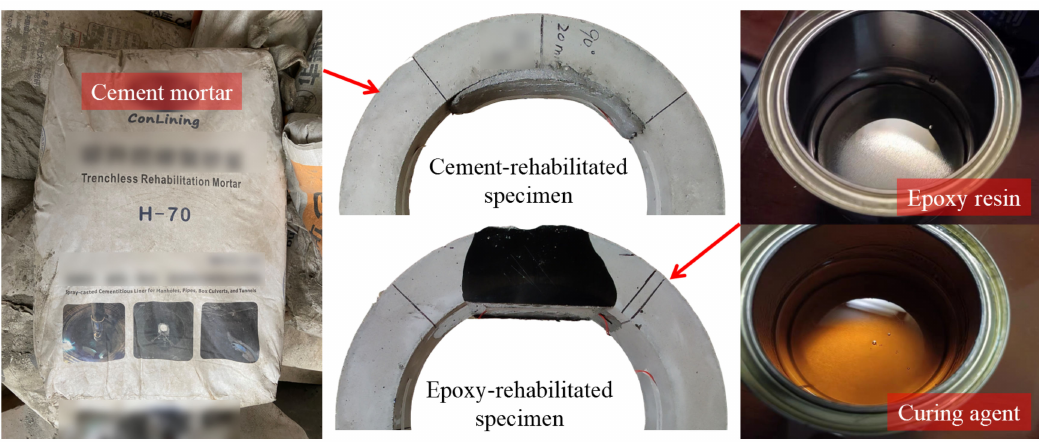
Figure 4. Cement mortar and epoxy resin used for pipe rehabilitation.